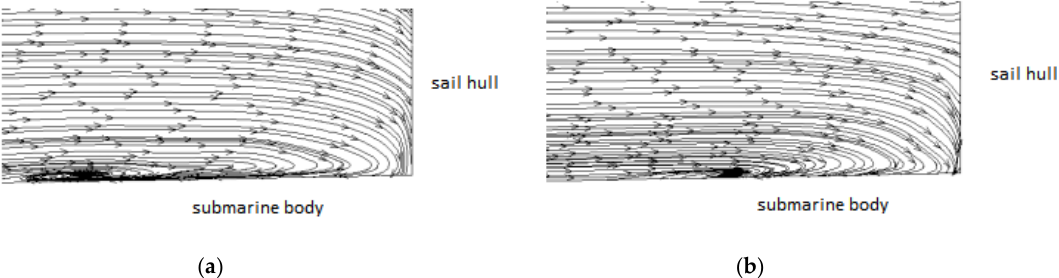
Figure 9. The streamlines at Plane B of the two models. ( a ) The original model; ( b ) The model with leading-edge serrations.